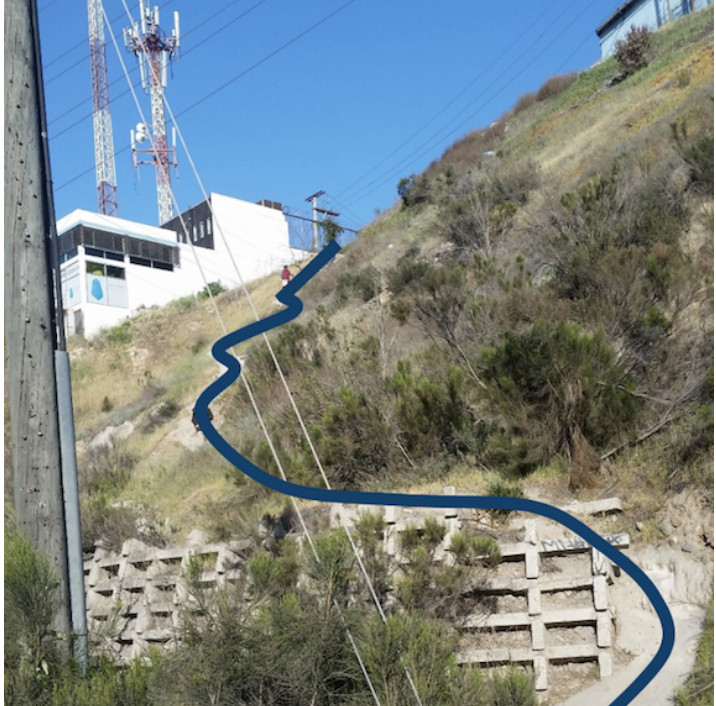
Figure 9. Carved-out path or shortcut (shown in blue) that people prefer to take as an alternative